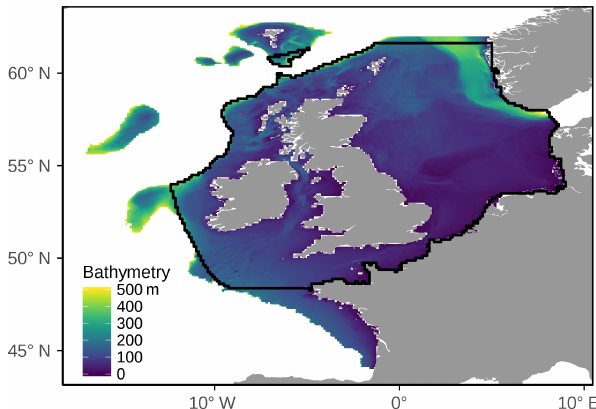
Figure 1. Region where the sedimentary environment was mapped. We defined the north-west European Shelf as the region between 17 ◦ W and 9 ◦ E and 44 and 63 ◦ N, where bathymetry was less than 500m. The solid black line demarcates the region where tidal ve- locities were taken from the Scottish Shelf Model, as described in Sect.